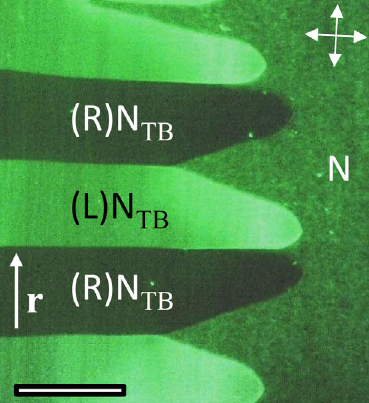
FIG. 16. Powder x-ray diffractograms of a BP12 sample in the crystalline, M , N , and N phases. The inset shows a magni- X TB fication of the low-angle region.